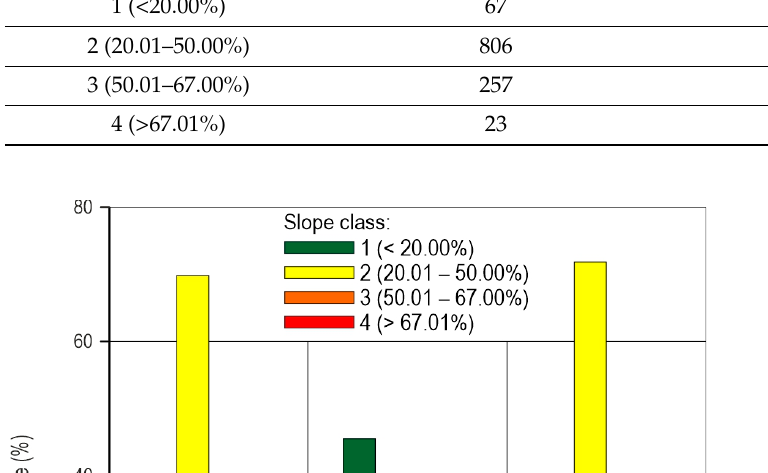
values graphically shown in Figure 2.